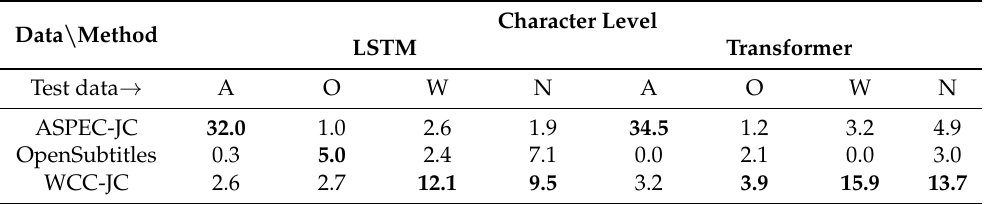
Table 4. Japanese → Chinese translation experiment results in character level (BLEU values).